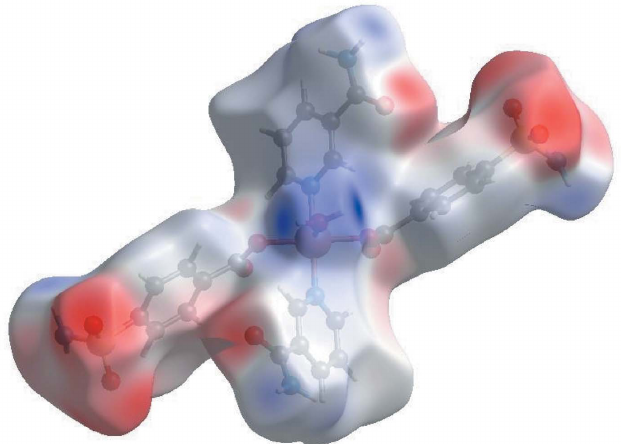
Figure 5 The full two-dimensional fingerprint plots for the title complex, showing ( a ) all interactions, and delineated into ( b ) H (cid:2)(cid:2)(cid:2) O/O (cid:2)(cid:2)(cid:2) H, ( c ) H (cid:2)(cid:2)(cid:2) H, ( d ) H (cid:2)(cid:2)(cid:2) C/C (cid:2)(cid:2)(cid:2) H, ( e ) H (cid:2)(cid:2)(cid:2) N/N (cid:2)(cid:2)(cid:2) H, ( f ) O (cid:2)(cid:2)(cid:2) C/C (cid:2)(cid:2)(cid:2) O, ( g ) O (cid:2)(cid:2)(cid:2) O and ( h ) N (cid:2)(cid:2)(cid:2) C/C (cid:2)(cid:2)(cid:2) N interactions. The d i and d e values are the closest internal and external distances (in A˚ ) from given points on the Hirshfeld surface